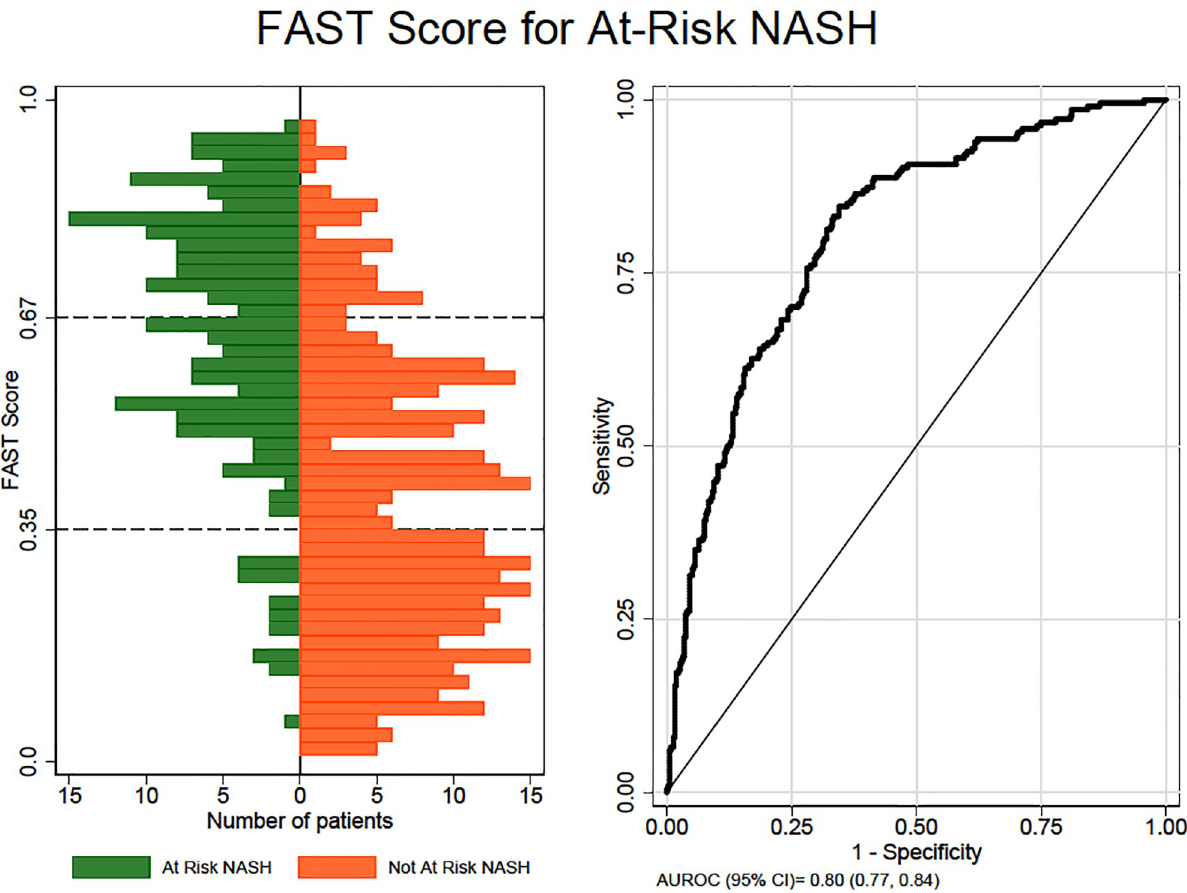
Fig 1. Diagnostic performance of FAST ™ score for detection of at-risk NASH in 585 NAFLD patients. On the left, histogram showing frequency distribution of FAST ™ scores by at-risk NASH status is depicted. Green color depicts scores for patients with at-risk NASH, and orange color shows scores for patients without at-risk NASH. The dotted lines show rule-out cut-off of 0.35 and rule-in cutoff of 0.67. On the right, AUROC of FAST ™ for the diagnosis of at-risk NASH is